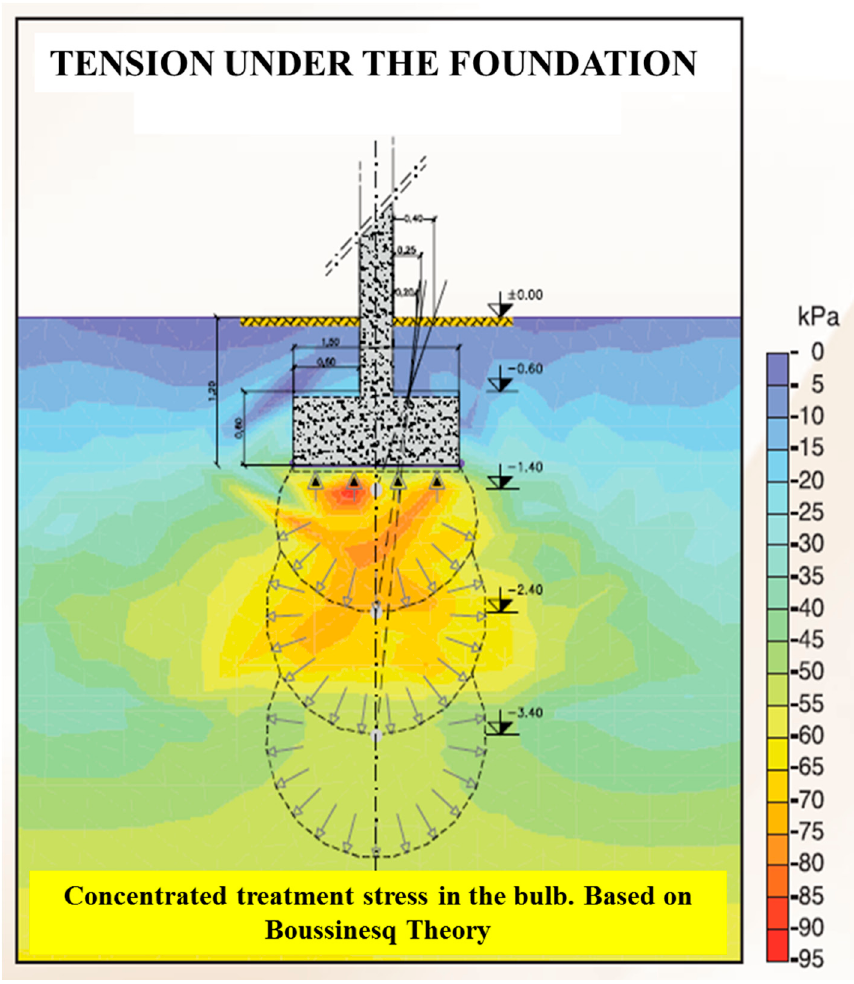
Figure 2. Tension status under the foundation after treatment.